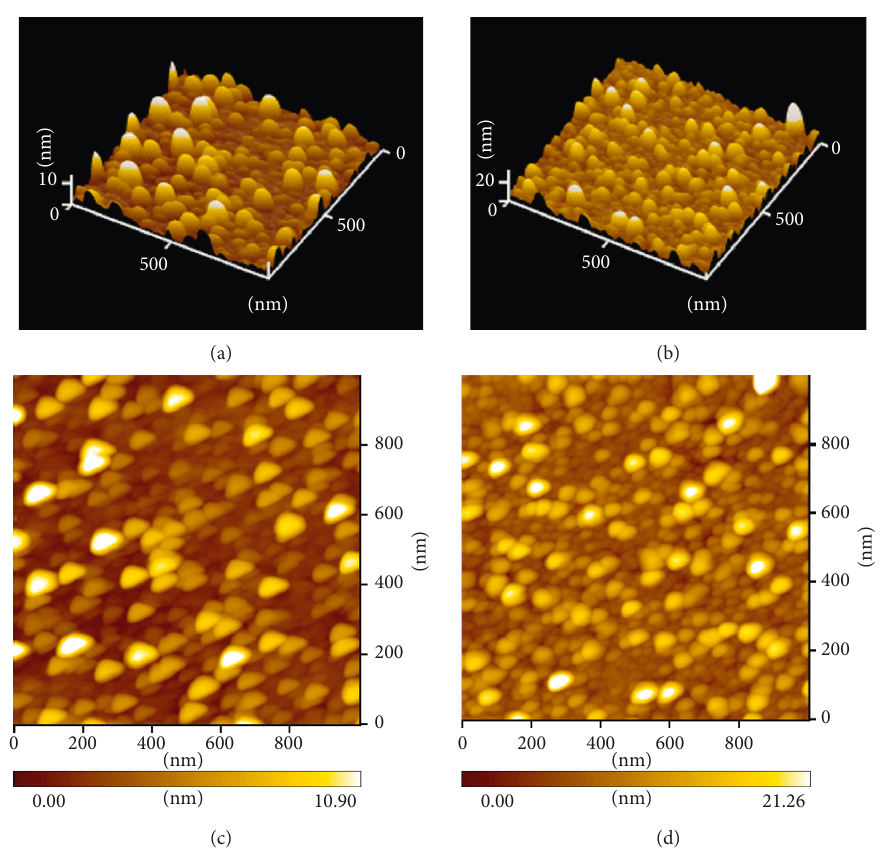
Figure 5: 3D AFM images of (a) bare TiO 2 films and (b) 0.1 at% of Fe-doped TiO 2 films; 2D AFM images of (c) TiO 2 films and (d) 0.1 at% of Fe-doped TiO 2 films.